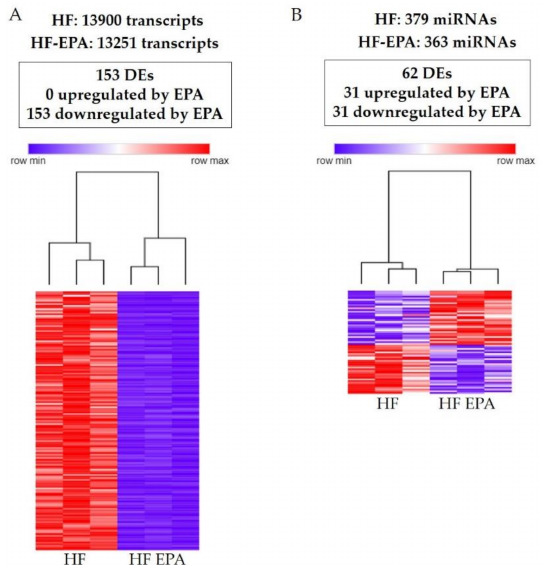
Figure 1. Gene and miRNA profiling and Hierarchical clustering process in obese B6 mice. ( A ). 153 DE genes identified following RNA sequencing for HF vs. HF-EPA in visceral adipose tissue (VAT). Zero genes were upregulated and 153 were respectively downregulated with EPA (false discovery rate (FDR)-adjusted p value ≤ 0.05, fold change ≥ 1.5, reads per kilo base per million mapped reads (RPKM) ≥ 0.3). Hierarchical clustering shows that 153 DE genes in VAT were di ff erentially regulated by EPA. The horizontal line represents the di ff erent diets (HF vs. HF-EPA), and the vertical line represents the list of genes. Lower values are represented with blue tones, while higher values have yellow tones (FDR-adjusted p value ≤ 0.05, fold change ≥ 1.5, RPKM ≥ 0.3). ( B ) 62 DE miRNAs were identified following RNA sequencing for HF vs. HF-EPA in VAT. Thirty-one miRNAs were upregulated and 31 were respectively downregulated by EPA (FDR-adjusted p value ≤ 0.05, log2 fold change > 1.25, RPKM ≥ 3.34). Hierarchical clustering demonstrates that 62 DE miRNAs in VAT were di ff erentially regulated by EPA. The horizontal line represents the di ff erent diets (HF vs. HF-EPA), and the vertical line represents the list of miRNAs. Lower values are represented with blue tones, while higher values have yellow tones (FDR-adjusted p value ≤ 0.05, log fold change > 1.25, RPKM ≥ 3.34). HF, high fat; HF-EPA, HF diet supplemented with EPA; DE, di ff erentially expressed. Table 1. Canonical pathways a ff ected by EPA supplementation in visceral adipose tissue of obese B6 mice. − log p value > 1.3 is equivalent to FDR-adjusted p value ≤ 0.05, Z score ≤ − 2 indicates pathway inhibited, Ratio is the number of di ff erentially expressed / total number of genes in a canonical pathway. Ingenuity Canonical Pathway